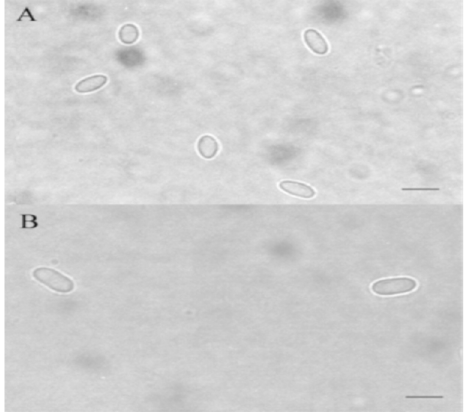
Figure 3. Nosema ceranae ( A ) and Nosema apis ( B ) spores in a phase contrast microscope. Sample- aqueous coating [9]. Scale bar is 5 μ m.